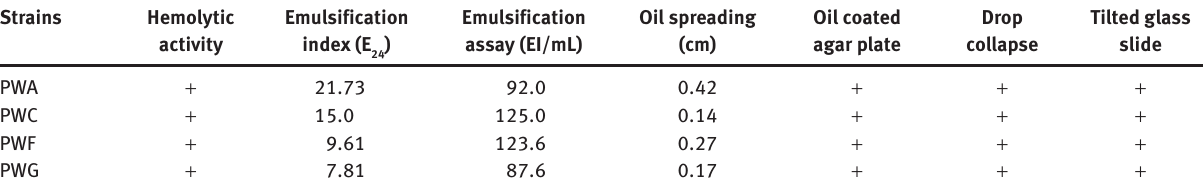
Table 1: Screening for biosurfactant producers.